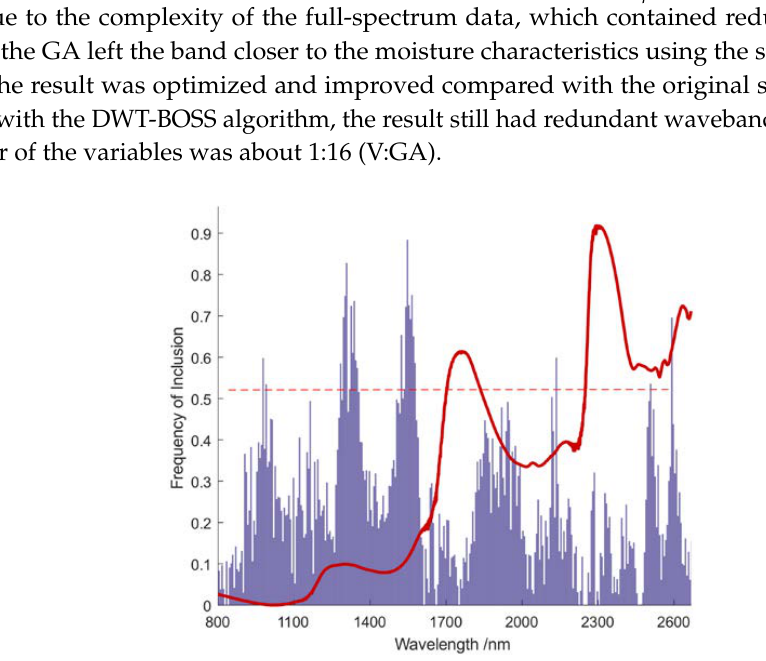
Figure 7. The frequencies of selected variables within 30 runs by the GA. Note: The selected wavelength is above the dotted line. Table 2. PLS model was established by different wavelength selection methods.